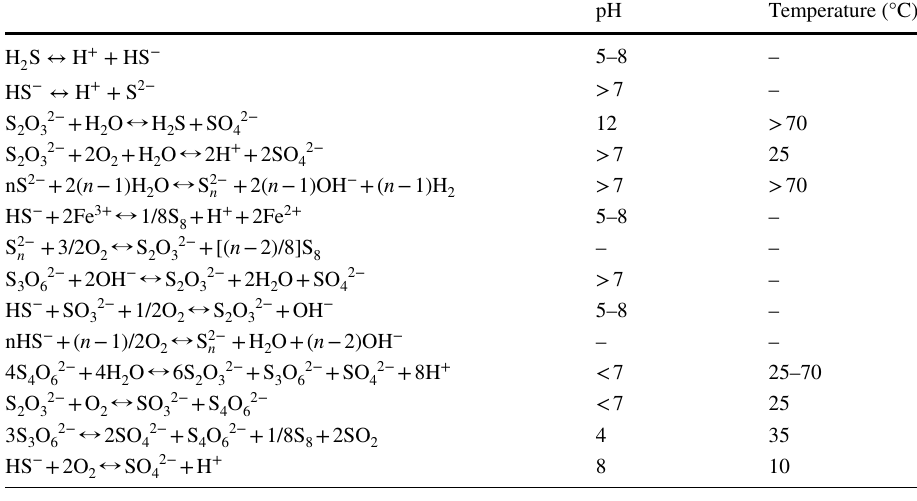
sulfur-containing compounds considered in this study at 25 °C (Machel 1987; Moses et al. 1987; Wilkin and Barnes 1996; Zhang and Millero 1991, 1993; Heinen and Lauwers 1996; Lin et al. 2004; Zhao et al. 2007; TengShui et al. 2009; Miranda- Trevino et al.